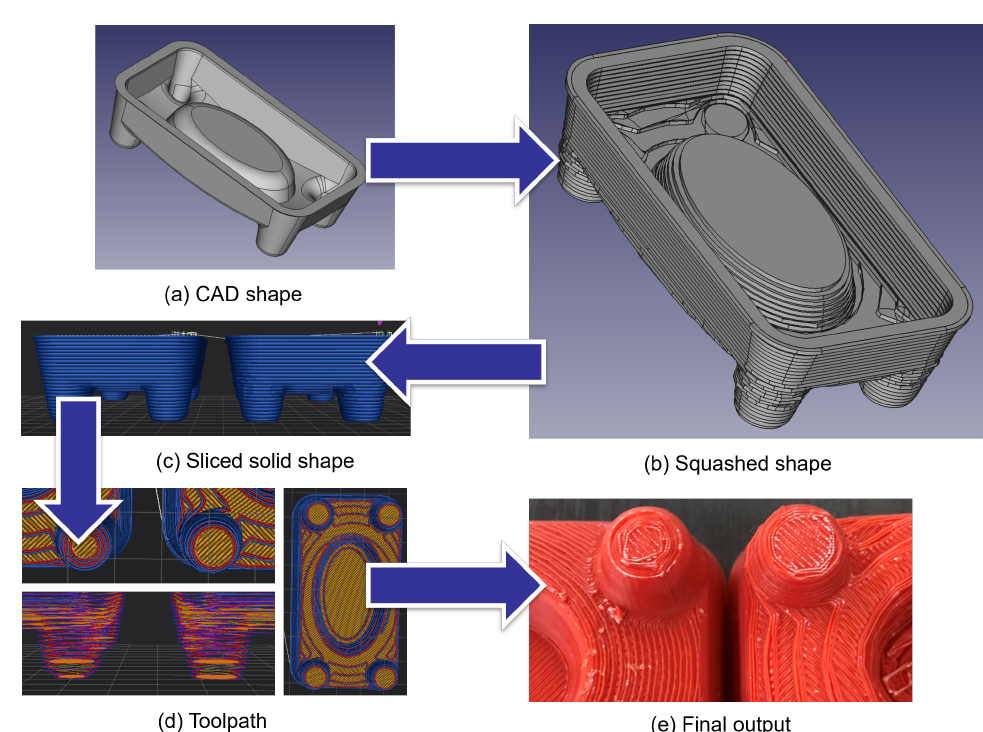
Figure 19. Comparison with different slicing algorithms: The squashed sliced shape ( b ) made from CAD shape ( a ) is compared with the legacy sliced shape in terms of side views ( c ), tool-paths ( d ), and the final output ( e